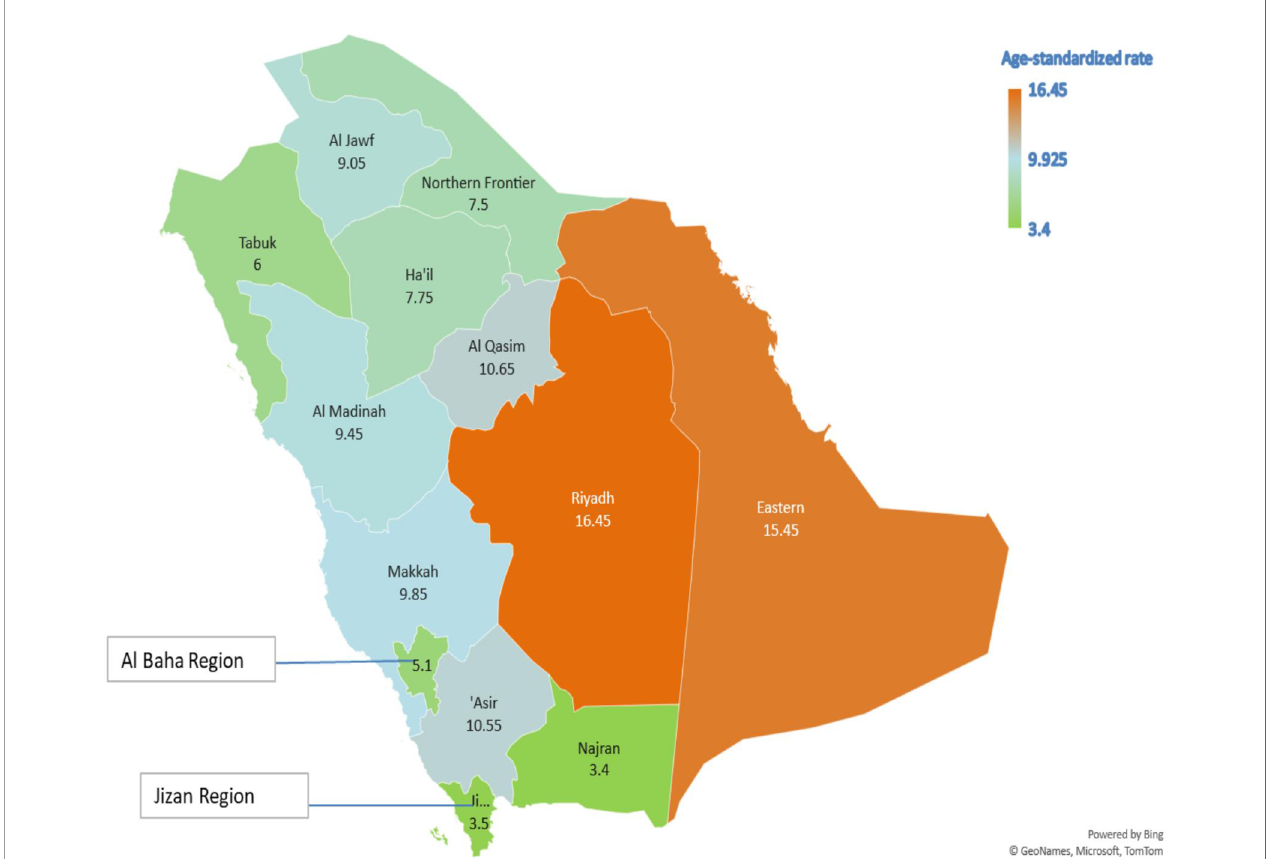
FIGURE 3 | The geographic distribution of the age-standardized incidence rates per 10 5 population, Saudi Arabia